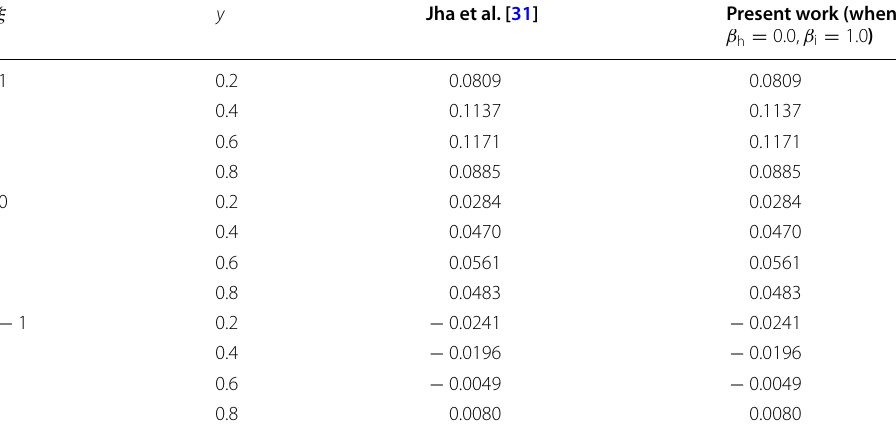
Table 1 Evaluation of velocity in the existing work (in the absence of Hall effect and ion-slip current) with Jha et al. [31] when M = 2.0, P m = 0.5, S = 0.5, β v Kn = 0.05,ln = 1.667 ξ y Jha et al. [31] Present work (when